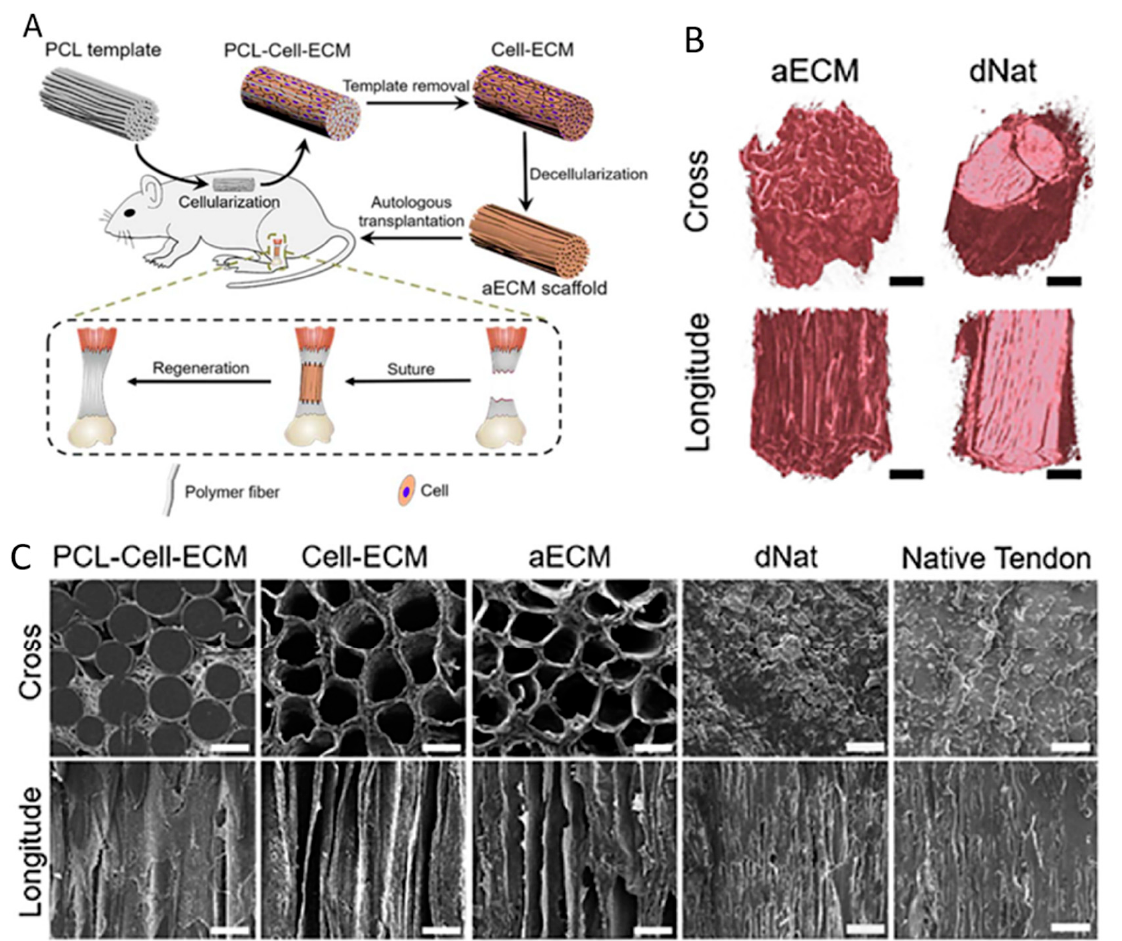
Figure 3. Polycaprolactone (PCL)–cell–ECM scaffolds support tendon regeneration. ( A ) Schematic of the scaffolds and implantation procedure. ( B ) Micro-CT scans of the transverse and longitudinal position in the aECM and dNat scaffolds. ( C ) PCL–cell–ECM, cell–ECM, aECM, decellularized native tendon (dNat) scaffold and native tendon microstructures were visualized using SEM cross- (top panels) and longitude- (bottom panels) sections. The figure was adapted with permission from Li et. al. 2019 [85].